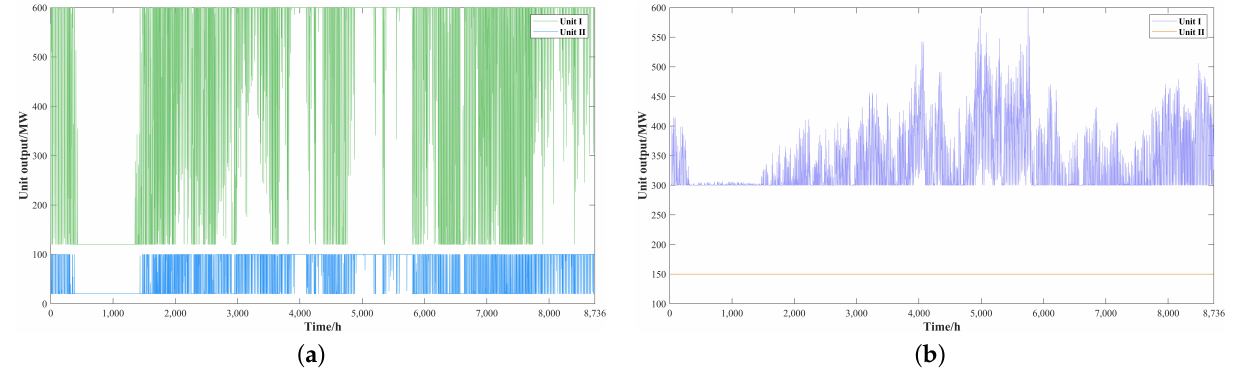
Figure 9. The output power curve of the unit in the entire time period of case A. ( a ) The output power curve of hydroelectric power units. ( b ) The output power curve of hydroelectric thermal power